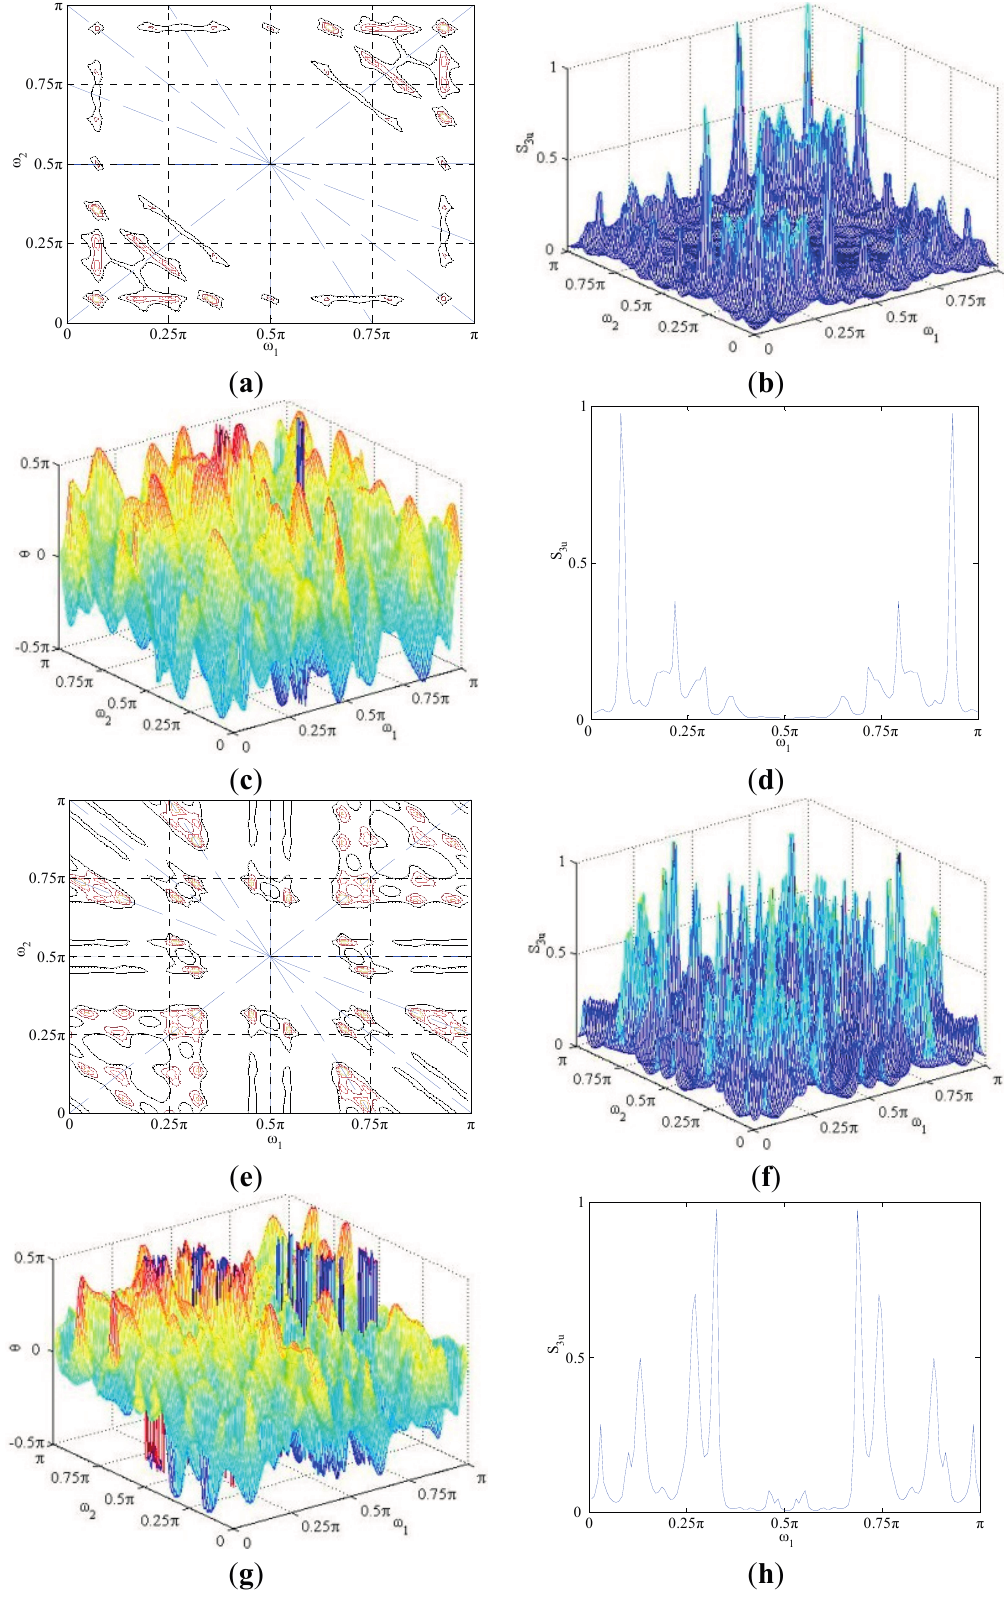
Figure 6. AR bispectra of electrical drill. ( a ) Normal contour; ( b ) Normal amplitude; ( c ) Normal phase angle; ( d ) Normal 1½ - D slices; ( e ) Arc fault contour; ( f ) Arc fault amplitude; ( g ) Arc fault phase angle; ( h ) Arc fault 1½-D